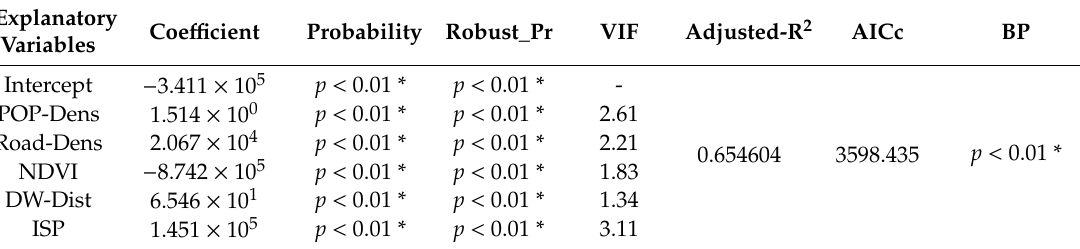
Table 3. Relevant parameters of OLS Model